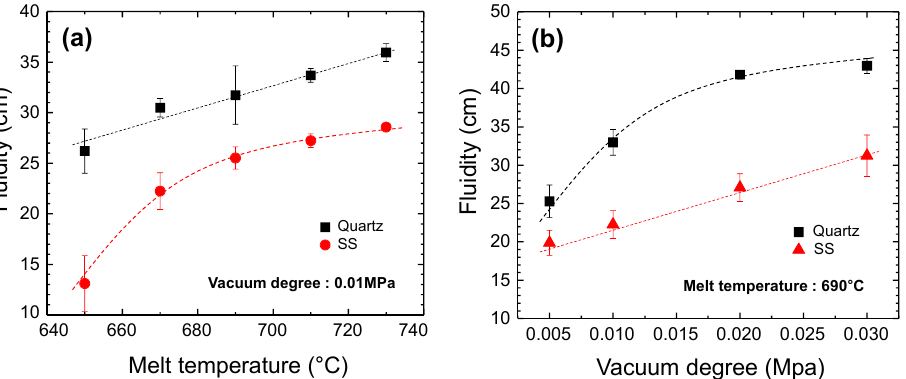
Figure 6. The effect of tube materials on the fluidity in the A356 alloy with respect to ( a ) melt temperature and ( b ) vacuum